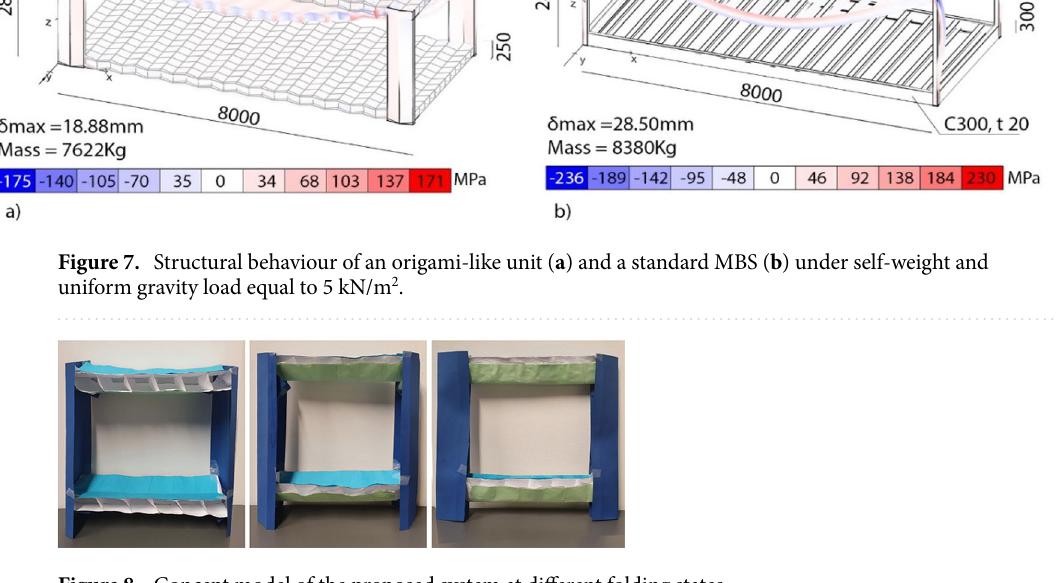
Figure 8. Concept model of the proposed system at different folding